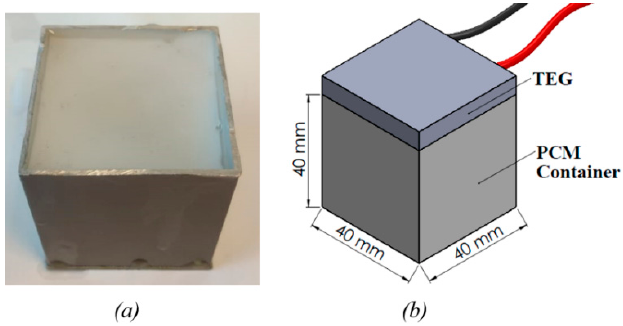
Figure 12. Experimental setup: ( a ) PCM container; ( b ) General assembly drawing.